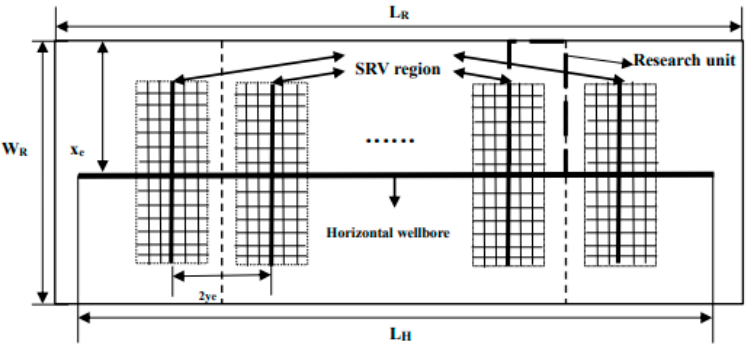
Figure 1. Schematic of a multi-fractured horizontal well in a volcanic oil reservoir.